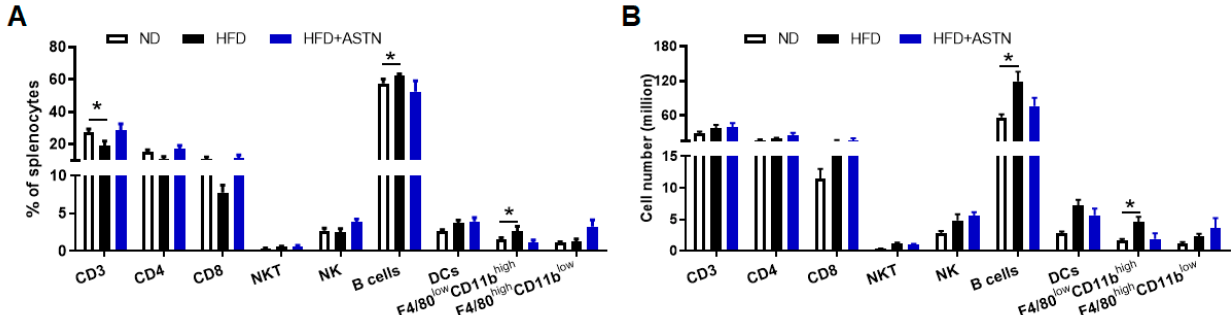
Figure 6. Astaxanthin treatment does not significantly modulate the systemic immune response. Spleen lymphocytes with lysis of erythrocytes were isolated from spleens of ND, HFD, and HFD + ASTN-treated mice simultaneously as liver tissues in Figure 5, stained with fluorochrome-conjugated antibodies, and analyzed via flow cytometry. ( A ) The mean frequency and ( B ) the mean absolute cell number of different types of immune cells in the spleen, including CD3 (CD3 + ), CD4 (CD4 + CD3 + ), CD8 (CD8 + CD3 + ), NKT (NK1.1 + CD3 + ), NK (CD49b + CD3 − ), B cells (CD3 ‒ B220 + ), DCs (CD11c + CD11b + ), and F4/80 high CD11b low and F4/80 low CD11b high macrophages. n = 5, error bars represent the mean ± SD. Statistical analysis of data was performed by one-way ANOVA using GraphPad Prism 8 software. * p < 0.05.